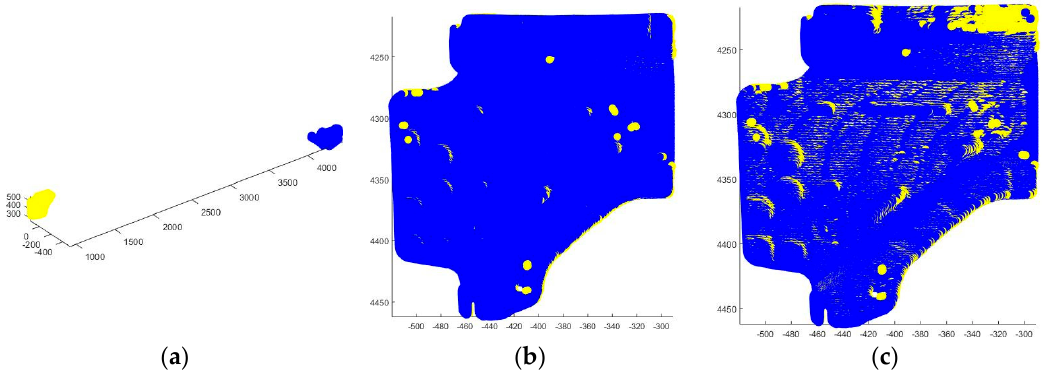
Figure 17. PCD after registration in Figure 10h.( a ) is the initial position of the point cloud, ( b ) is the result of coarse registration, and ( c ) is the result of fine registration